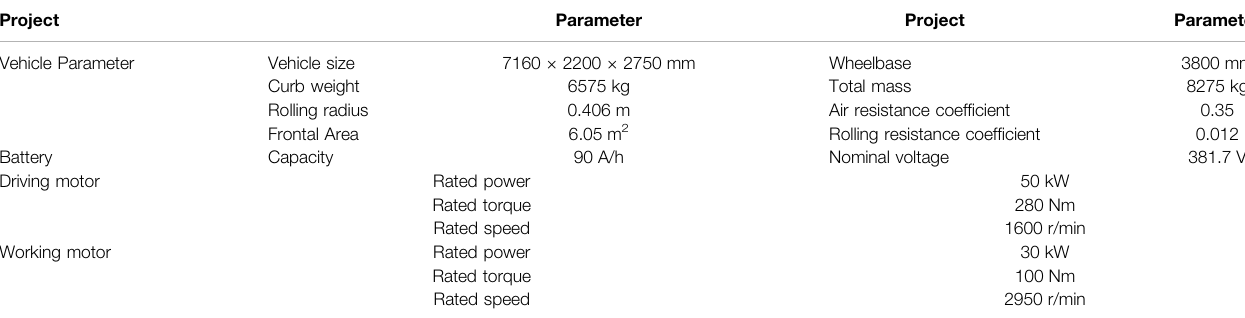
TABLE 1 | Vehicle and motor